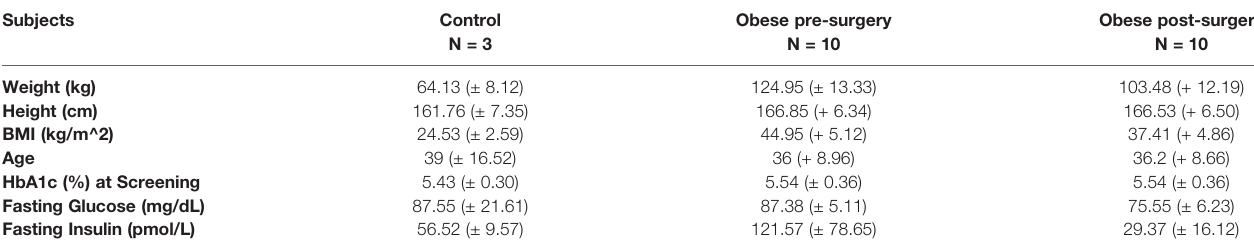
TABLE 1 | Human Study Subject Characteristics (Gene Expression Experiments). Subjects